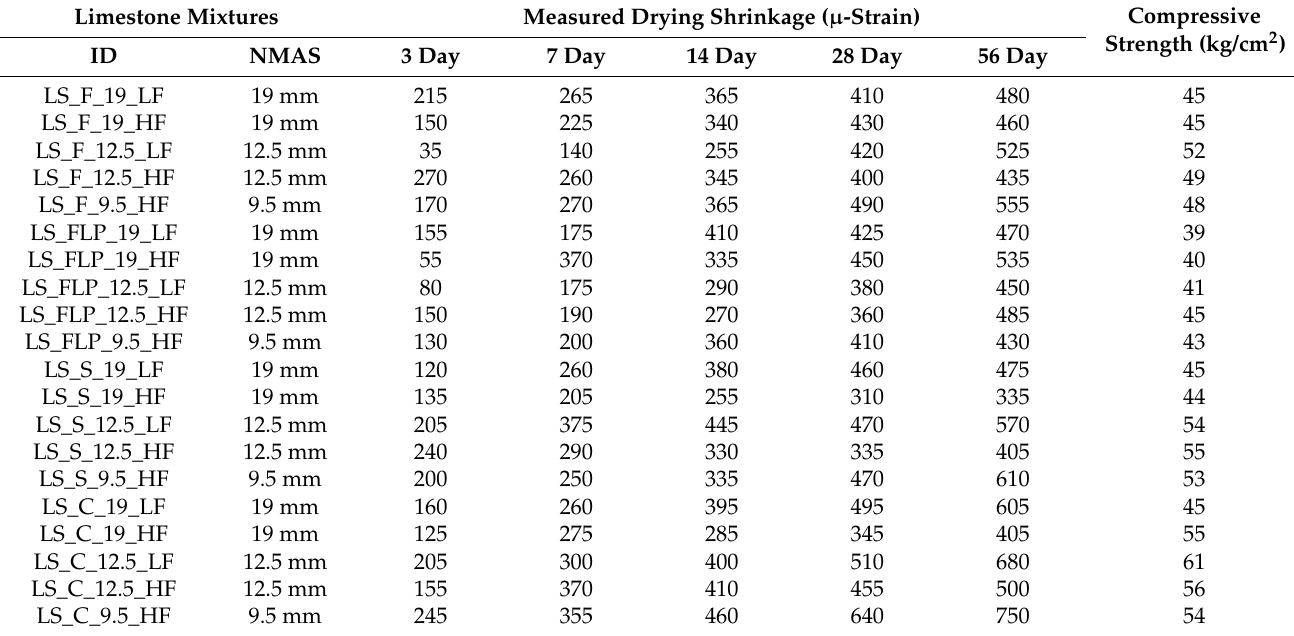
Table 9. Measured drying shrinkage of SCC mixtures containing limestone aggregate (25 mm = 1 in.; 1 kg/cm 2 = 14.2 psi). Limestone Mixtures